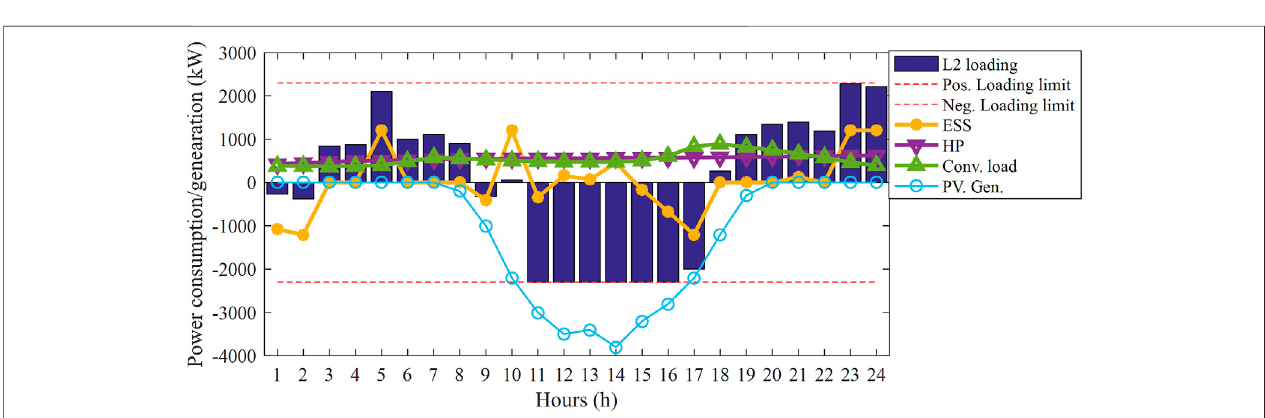
FIGURE 10 | Line loading of L2 and DER energy schedules after congestion management in scenario 4